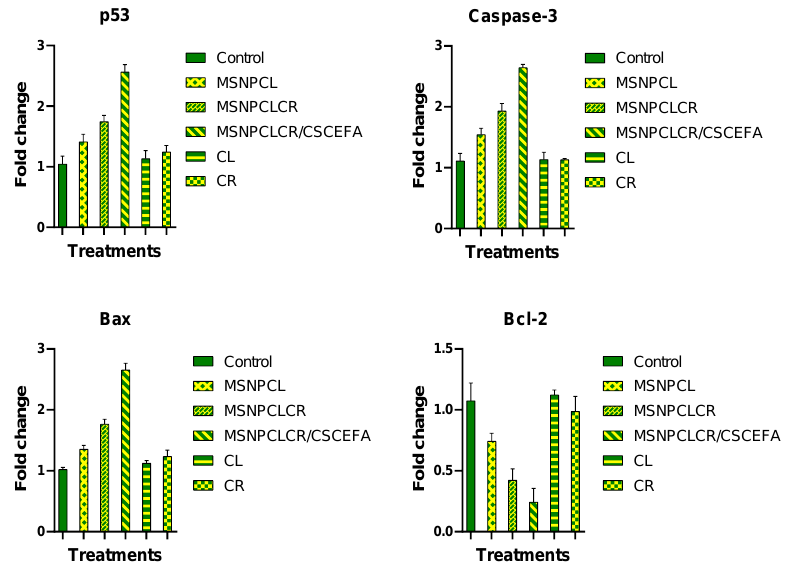
Figure 8. RT–PCR measurements of p53, caspase-3, Bax, and Bcl-2 markers of apoptosis for nanofor- mulations compared with free CL and CR against HCT-116 cancer cells treated at the IC50 concen- tration ( µ g/mL) of each formulation by incubation for 72 h. Data are presented as mean ± SD. The concentration was prepared for nanoformulations as an equivalent concentration of CL and CR in the nanoformulation equal to free CL and